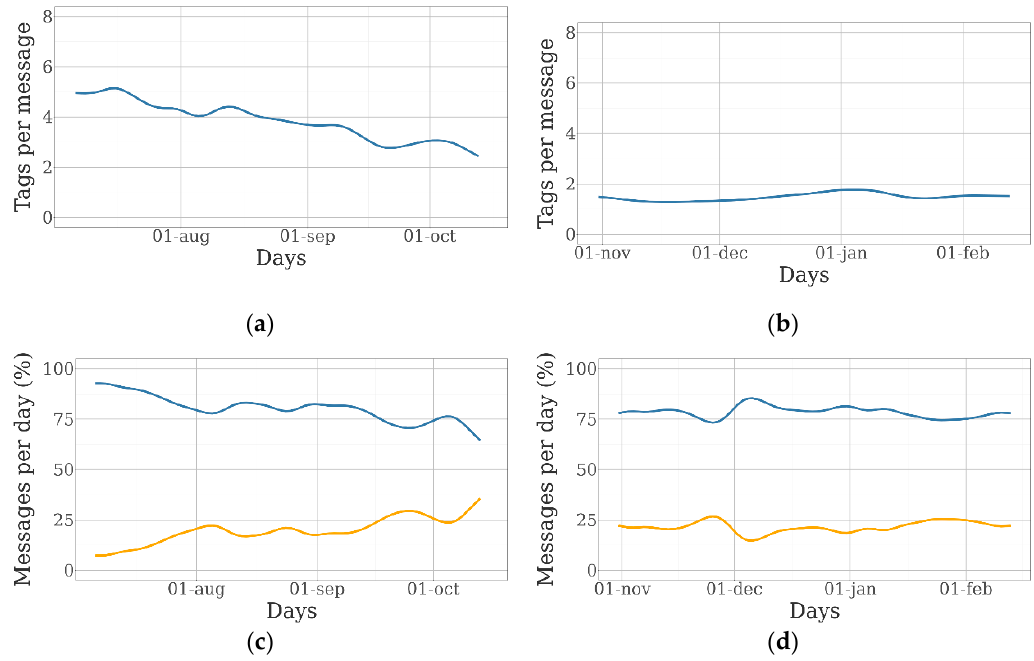
Figure 5. Evolution of the number of tag messages per GPS collar and the percentage of collar messages with (blue line) and without (orange line) over the experiment (25 collars and 25 tags): ( a , c ) sheep farm; and ( b , d ) beef cattle farm.